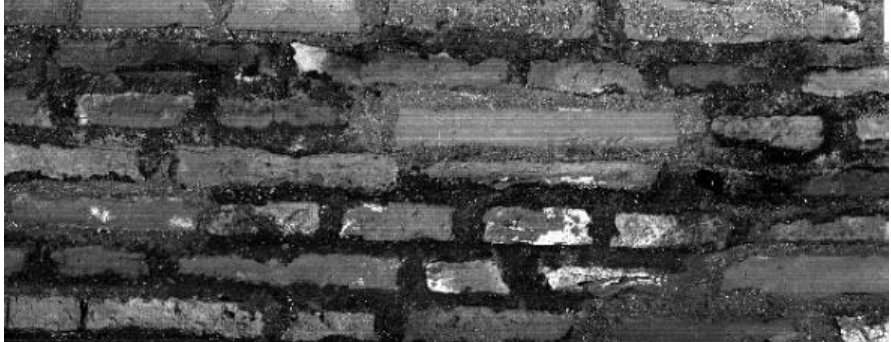
Figure 12. SAM error.